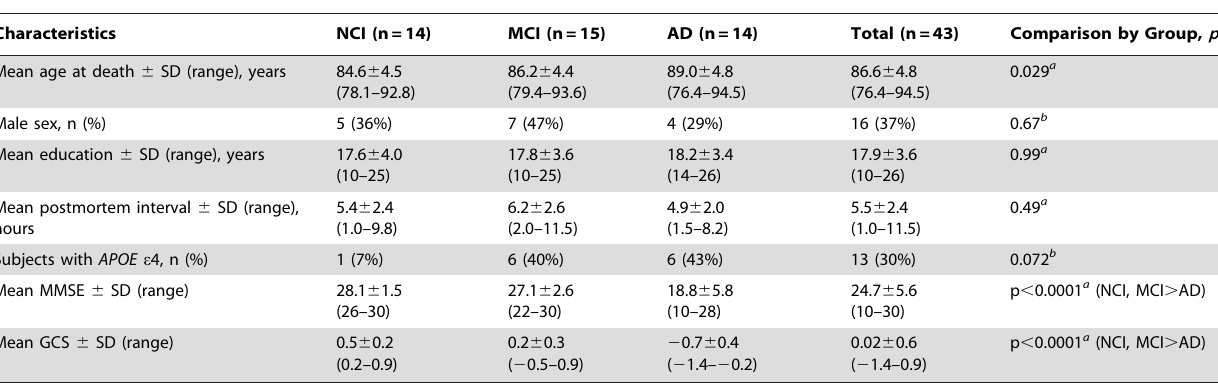
Table 1. Clinical and demographic characteristics by diagnostic group.